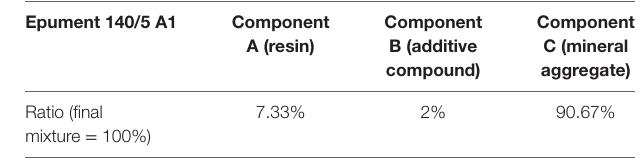
Table 1 | Material mixture.